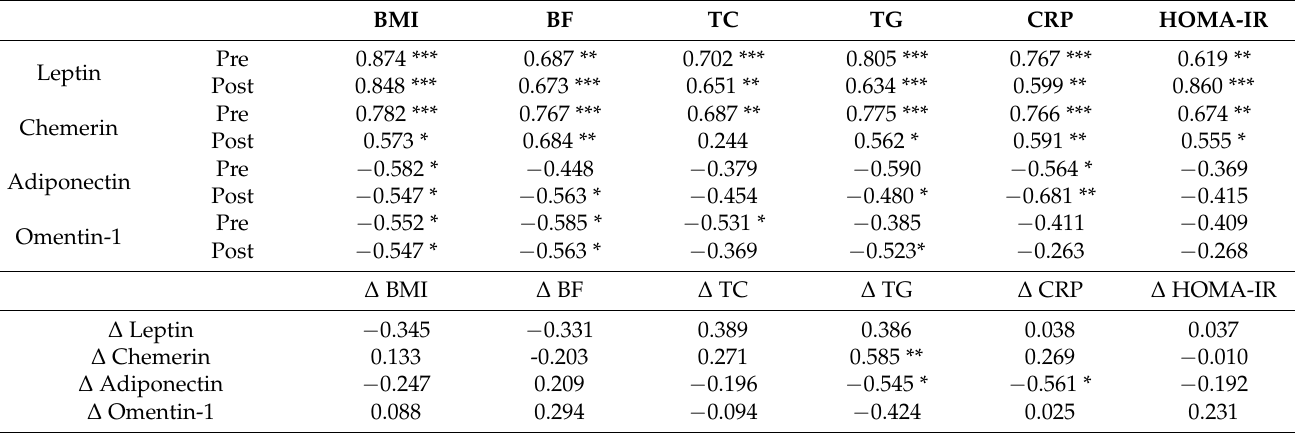
Table 2. Correlations of pre-training (Pre) and post-training (Post) adipokines levels with car- diometabolic risk markers and of their respective training-induced